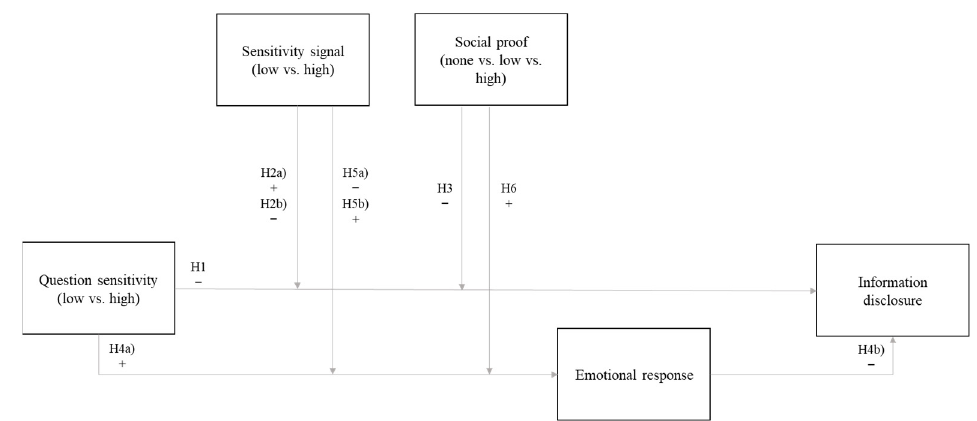
Figure 1. Research Model.